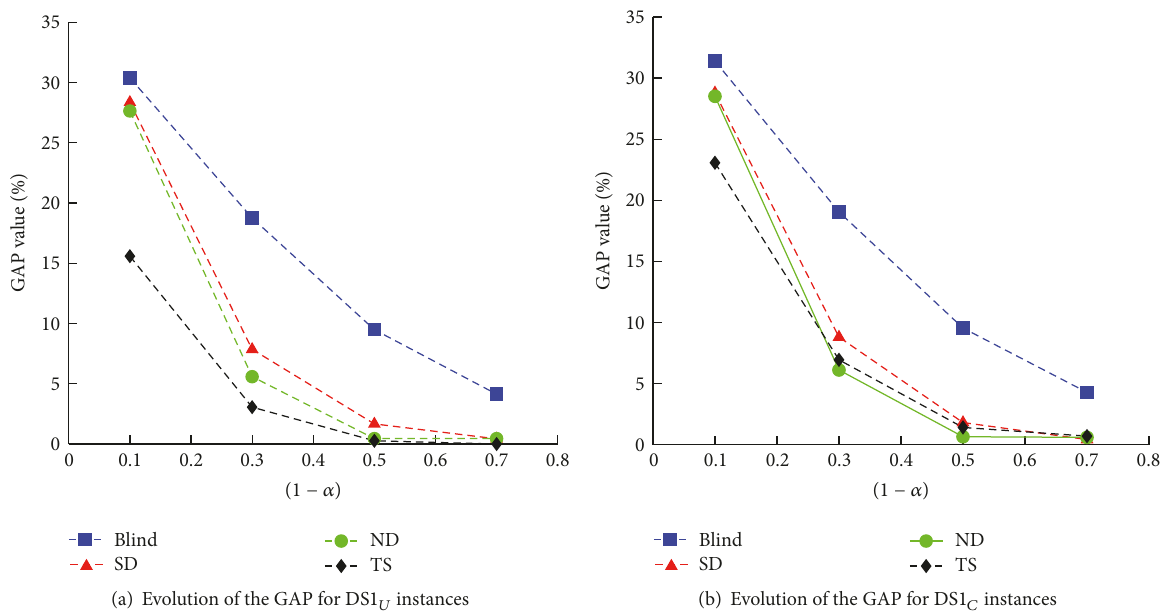
Figure 7: Average GAP values obtained by the local search algorithms for each value of (1 − 𝛼) for DS 1